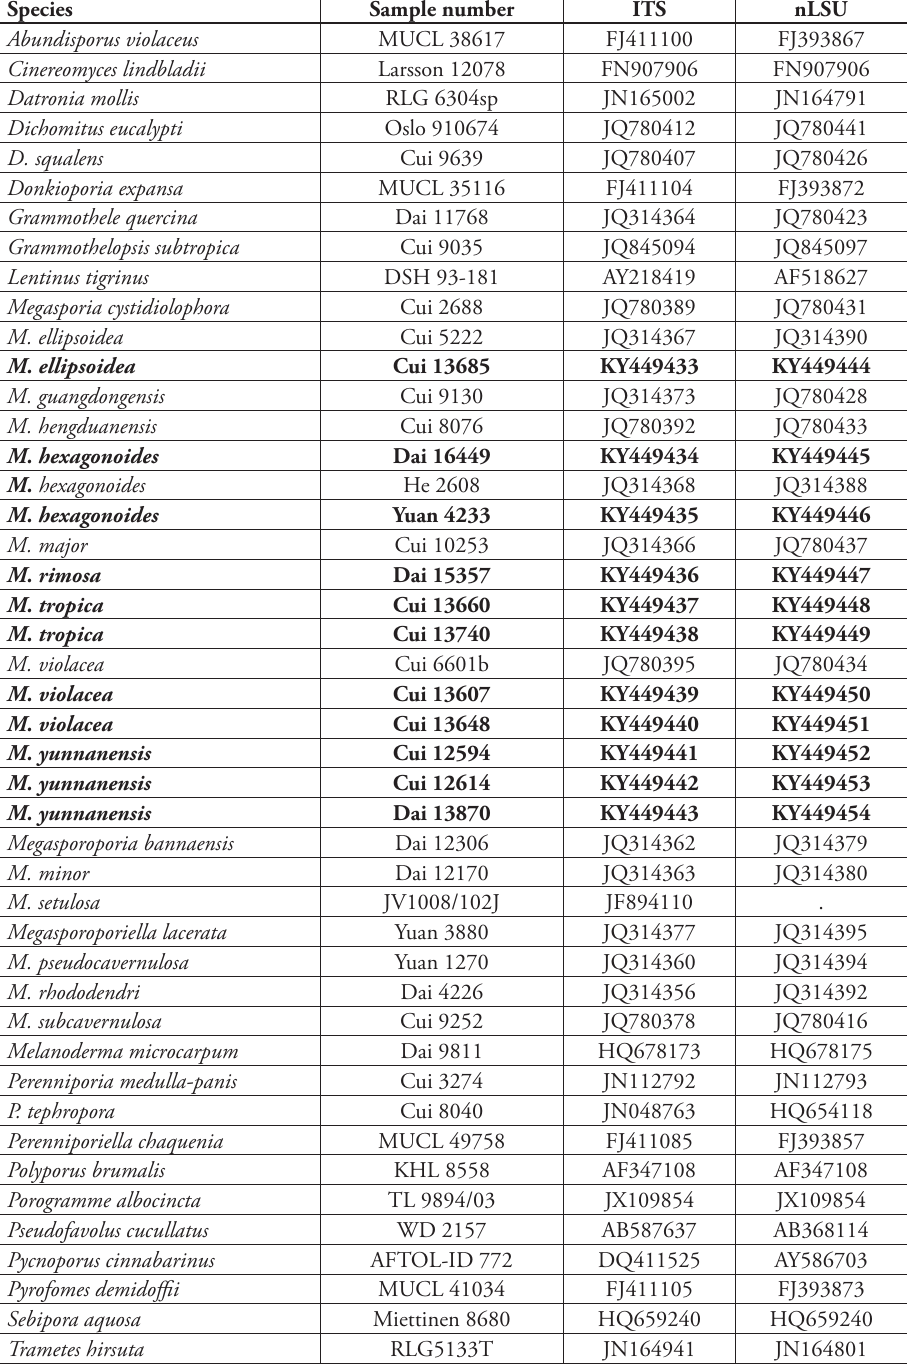
Table 1. A list of species, specimens and GenBank accession numbers of sequences used in this study. Species Sample